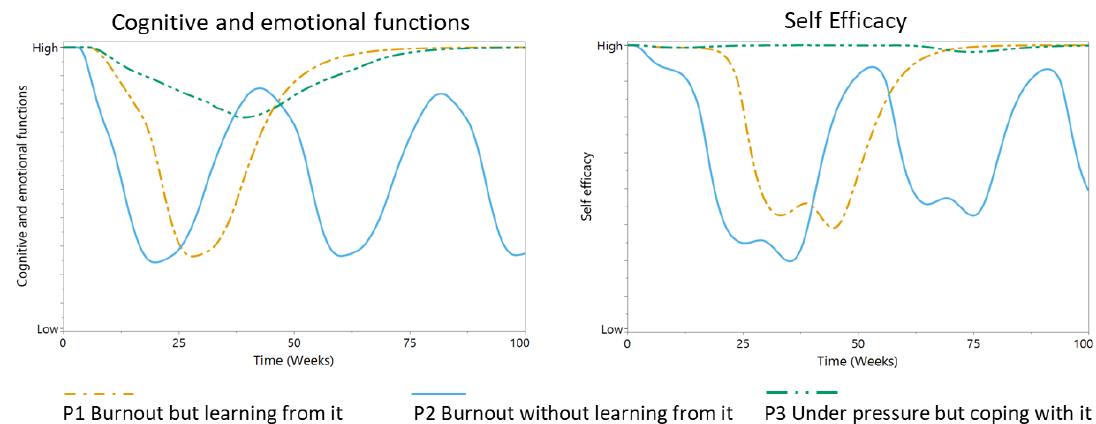
Figures Figure 7. Model behavior patterns for “demands” and “e ff ort”, parameterized for the simulations of Veldhuis et al : A proof-of-concept System Dynamics simulation model of burnout and recovery using retrospective case data personas (P): P1 “burnout but learning from it” (orange dotted line), P2 “burnout without learning Figure 7. Model behavior patterns for 'Demands' and 'Effort', parameterized for the simulations of personas (P). P1 'Burnout but learning from it' (orange dotted line), from it, (blue line) and P3 “under pressure but coping with it” (green dotted line). P2 'Burnout without learning from it' (blue line) and P3 'under pressure but coping with it' (green dotted line). Simulated with VENSIM PLE © v7.0.